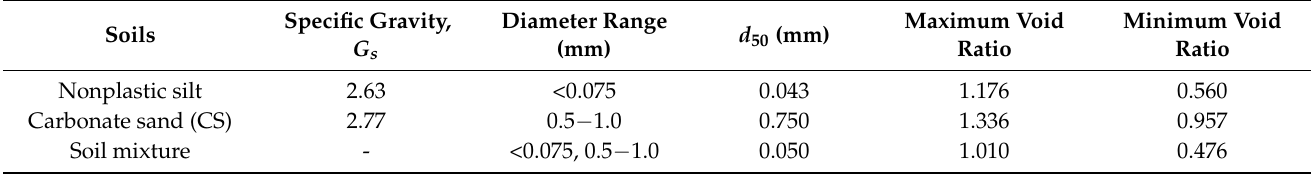
Figure 1. Particle size distribution of the CS–silt mixture [23]. Table 1. Physical properties of the tested